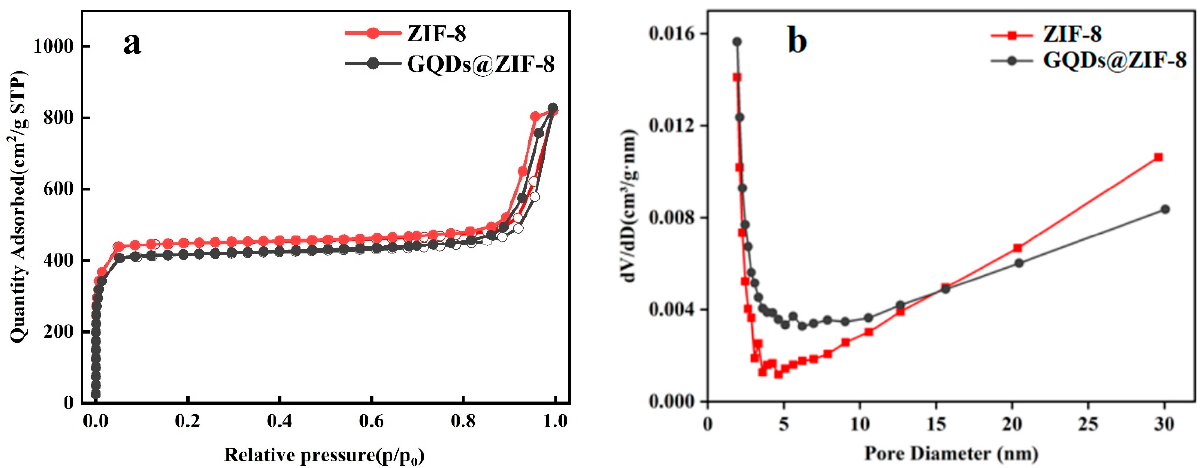
Figure 6. N 2 adsorption–desorption isotherms with the hollow dots corresponding to adsorption process and the solid dots corresponding to desorption process ( a ), and pore size distribution ( b ) of ZIF-8 and GQDs@ZIF-8 composites.